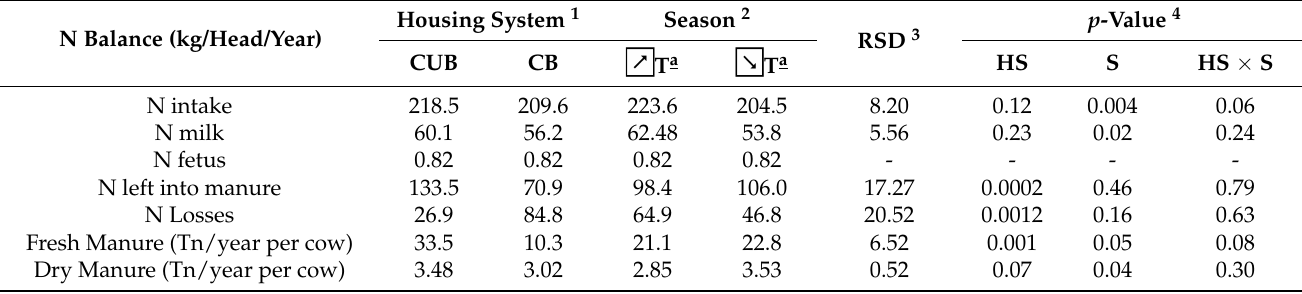
Table 2. Annual N balance (kg/head/year) and total fresh and dry manure production (considering 83.6% days in milk) in two housing systems and two seasons. N Balance